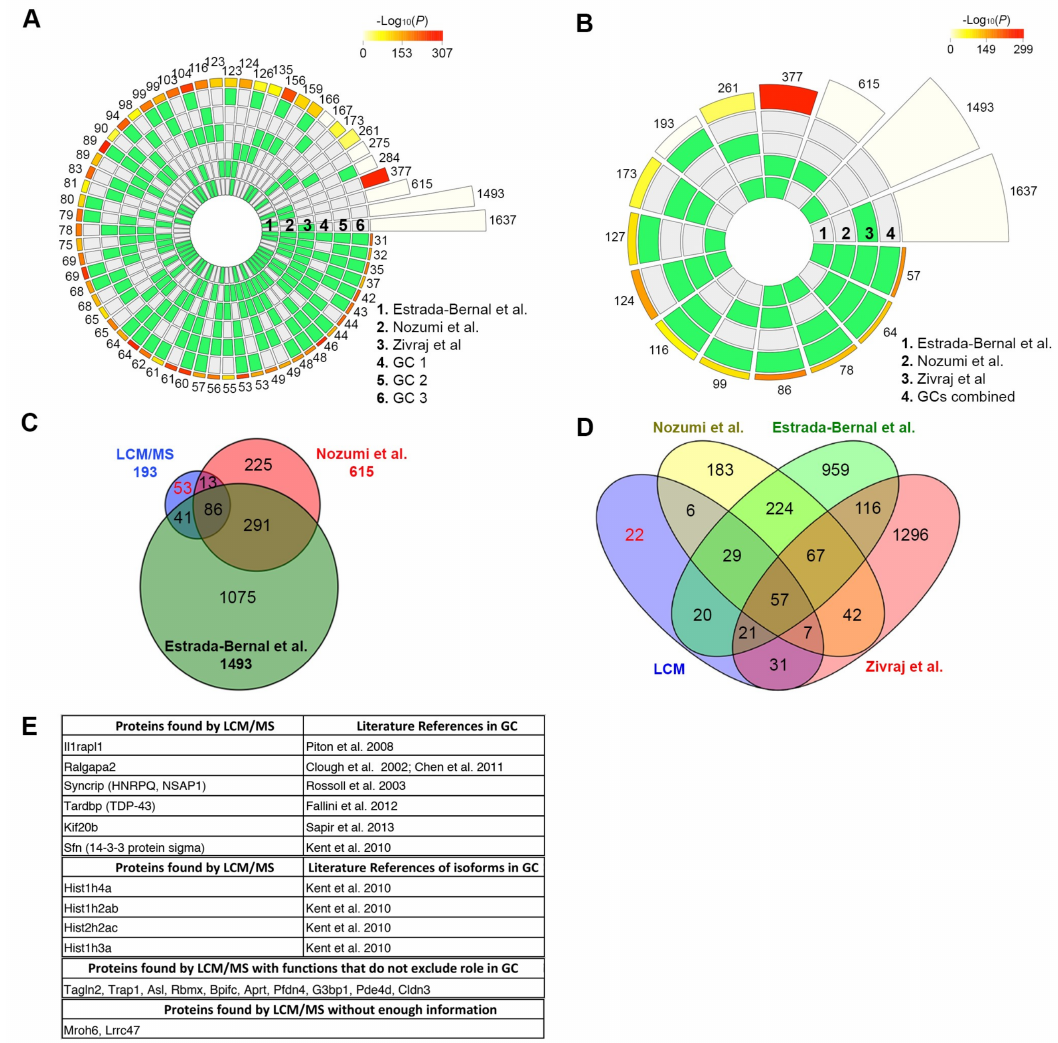
Figure 4. Mass spectrometry analysis of isolated growth cones. GCs from CADs were isolated by LCM and analyzed by MS. Circular plots showing the intersections and the corresponding statistics of the significant proteins identified by MS from ( A ) three independent LCM isolated GC samples (GC 1–3) or ( B ) the combined triplicate GCs compared to the proteins from proteomics [12,13] and transcriptomics studies [22] are shown. Overall, the GC proteins identified by LCM/MS matched very well with prior published data, suggesting that our isolation method is precise and that our MS analysis with a small sample is accurate. Venn diagrams of the 193 significant proteins, found in at least two of the triplicate GC samples are shown compared to ( C ) proteins identified from proteomics studies [12,13] or ( D ) proteomics [12,13] and transcriptomics [22] studies. High degrees of overlap are observed with only 53 proteins not identified in previous proteomics studies and only 22 proteins when combined with transcriptomics data. ( E ) Computation of the literature searches of the 22 proteins identified by LCM/MS, but not found in any of the other three studies, were grouped as (1) proteins found in the literature in GCs [32–38]; (2) with isoforms found in GCs; (3) proteins whose functions do not preclude a role in GCs; or (4) proteins without enough info. Overall, 93.8% of the proteins we identified were associated with GCs and 5.2% had functions consistent with GCs, further validating our LCM/MS